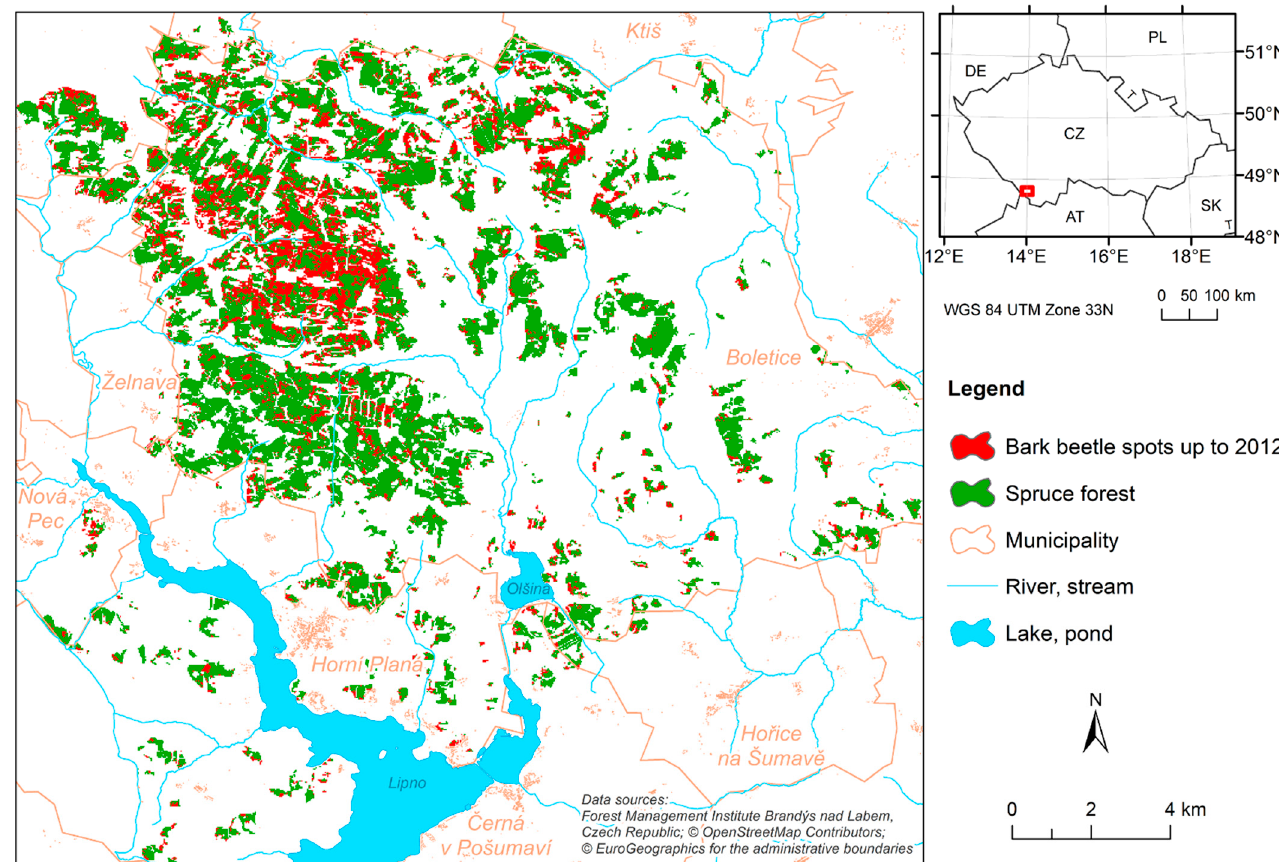
Figure 1. Location of the study area in the Czech Republic.